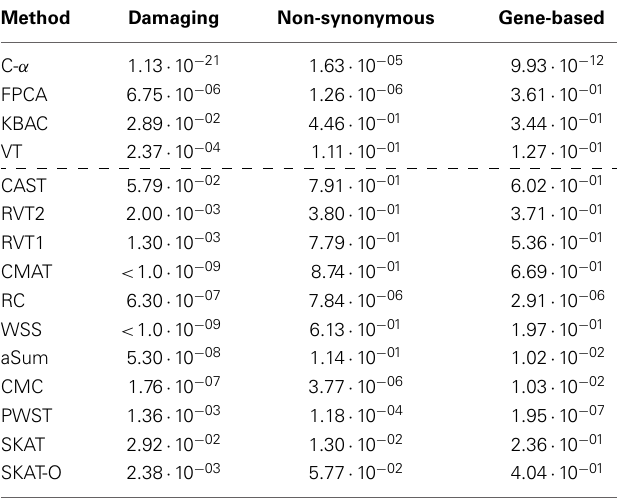
Table 2 | Type I error levels and power for collapsing with minor allele frequency < 0 . 01 for both non-synonymous and gene-based variants.